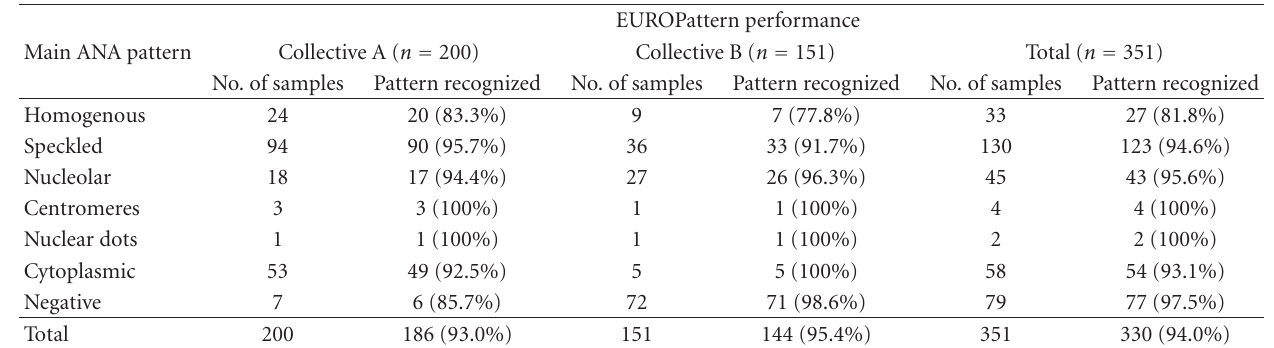
Table 2: Main pattern recognition by